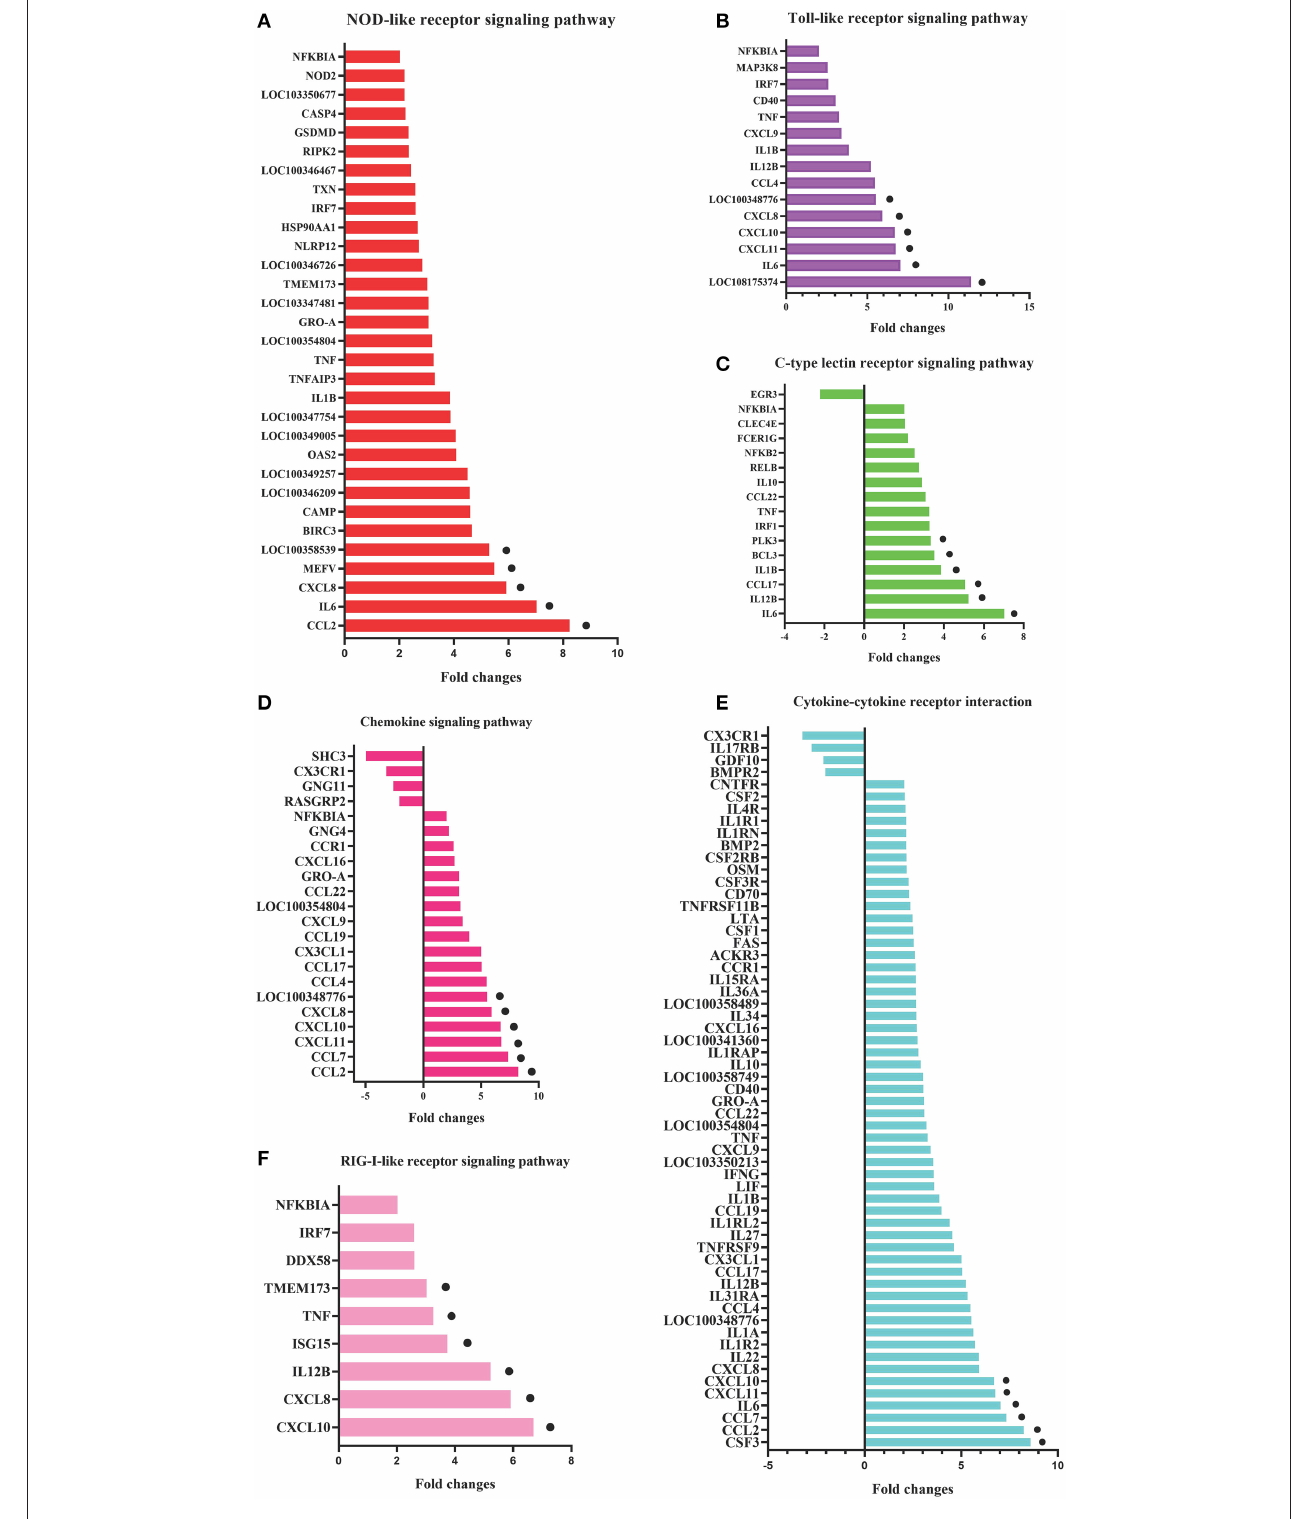
FIGURE 5 | DEGs in the six most enriched immune-related signaling pathways in the P0-vs.-P3 group with the fold changes ≥ 4. DEGs in the NOD-like receptor signaling pathway (A) , Toll-like receptor signaling pathway (B) , C-type lectin receptor signaling pathway (C) , chemokine signaling pathway (D) , cytokine-cytokine receptor interaction (E) , and RIG-I-like receptor signaling pathway (F) . The six DEGs with the most substantial fold changes in expression in each pathway marked by black dots.